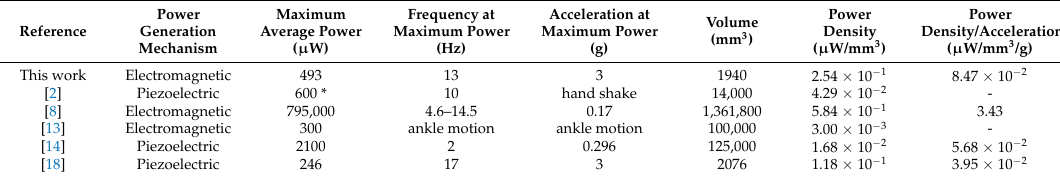
Table 2. Comparison of power generation performances of various harvesting